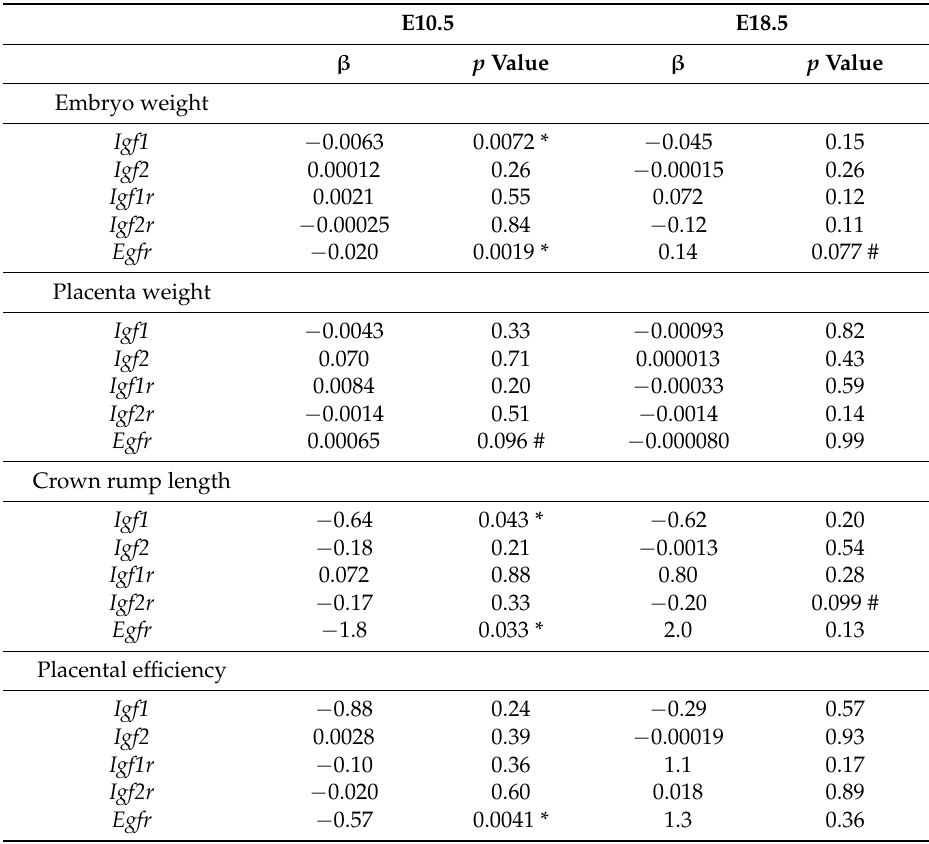
Table 4. Placental expression of growth-related genes as determinants of placental and fetal growth characteristics at E10.5 and E18.5. Data were analyzed using individual mixed linear models with gene fold change, treatment, genotype (for E10.5), and sex as fixed effects and maternal ID as a random effect. # p < 0.1, * p ≤